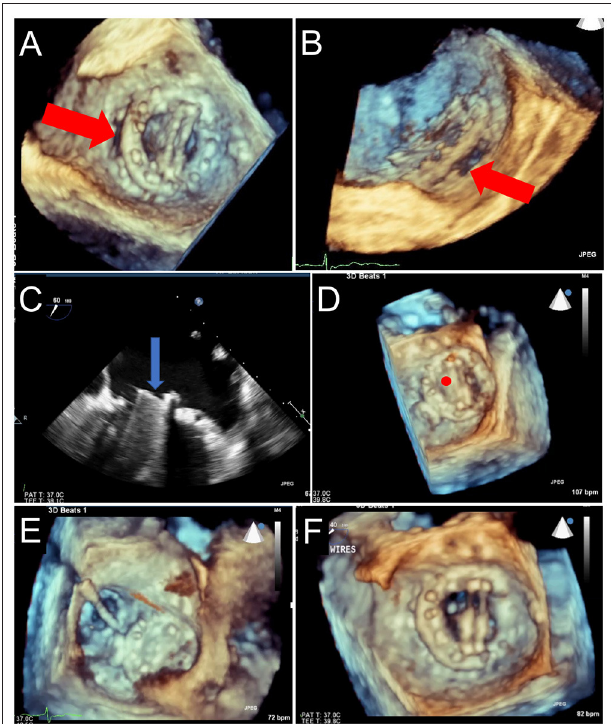
FIGURE 13 | Prosthetic Mechanical Leaflet Dysfunction Following PVL Closure. A large lateral paravalvular defect is seen (red arrows) from the surgical (A) and lateral (B) view. While initial deployment was successful, once the closure device was released from the delivery system, the lateral mechanical leaflet no longer opened during diastole due to interference from the ventricular aspect of the closure device (C , blue arrow, and D , red circle). After snaring to remove the closure device (E) , leaflet motion returned to normal (F)